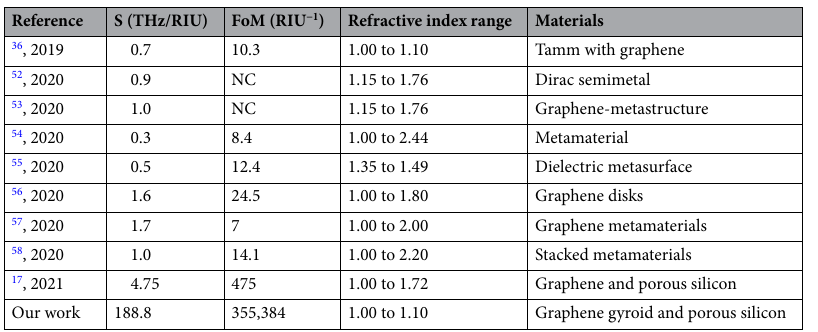
Table 2. Comparison with other designs performance ( NC not be